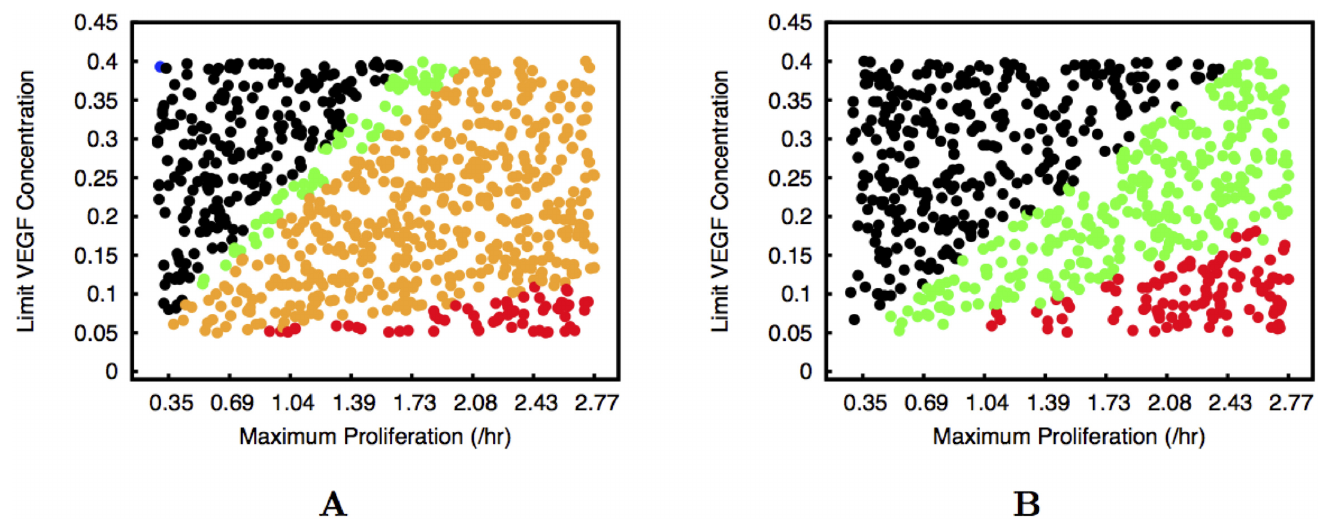
Fig 8. Morphology of the growing sprouts with low adhesion between endothelial cells. The two plates correspond to the cases of proliferation regulated by VEGF concentration (Plate A), and proliferation regulated by VEGF concentration but triggered by strain (Plate B). The colours indicate the morphology of the observed sprouts for each set of parameters. In both cases the black dots correspond to situations where vessel grows very slowly, not being able to reach a few cell widths in length after 14.5 hours. The red dots correspond to deformed vessels (triangular or with variable thickness), the orange dots correspond to sprouts that are straight but with a significantly thickened parental vessel, and the green dots correspond to well formed sprouts without appreciable thickening of the parental vessel. We observe that the proliferation is able to extend the short sprouts.